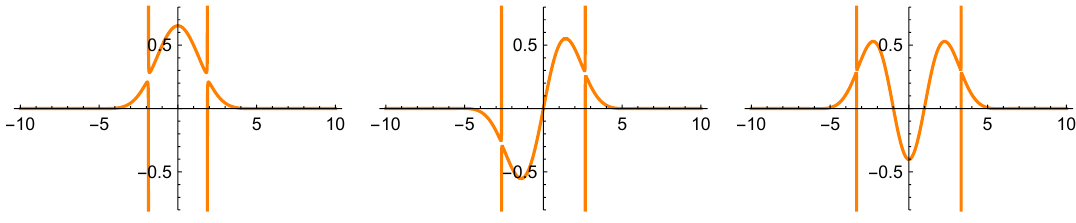
Figure 4. Gauge theory Baxter solution q ( (cid:27) ) for Q = 1, ~ = 1 : 5 at a not satisfying quantization